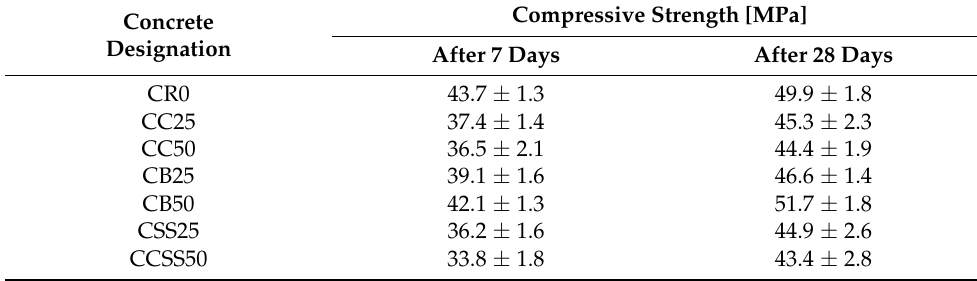
Table 2. Test results of concrete compressive